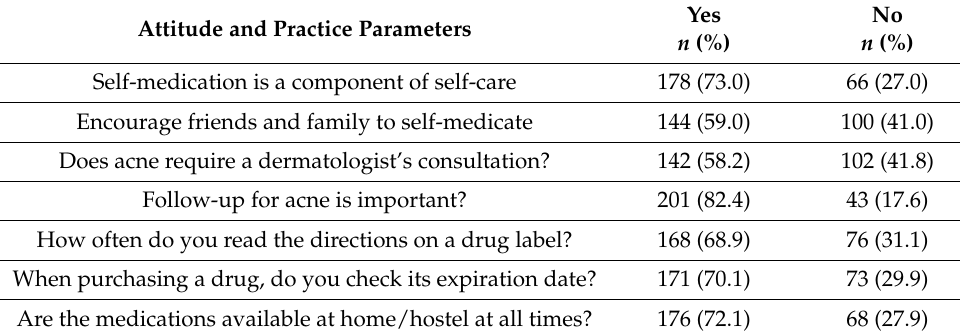
Table 9. Students’ attitude and practice towards self-medication ( n =